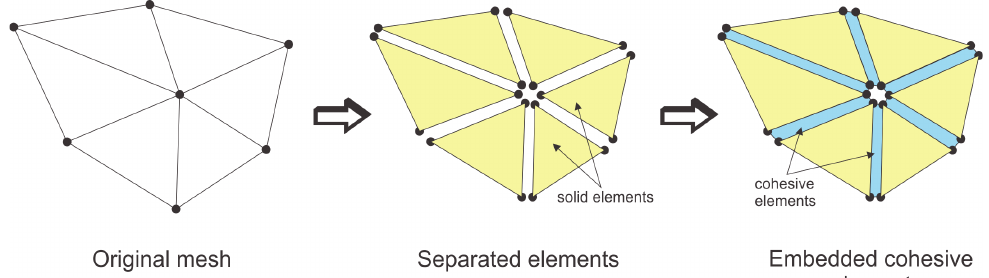
Figure 1: Procedure of embedding cohesive elements: original FE mesh; separated elements with duplicate nodes; cohesive elements embedded between all solid